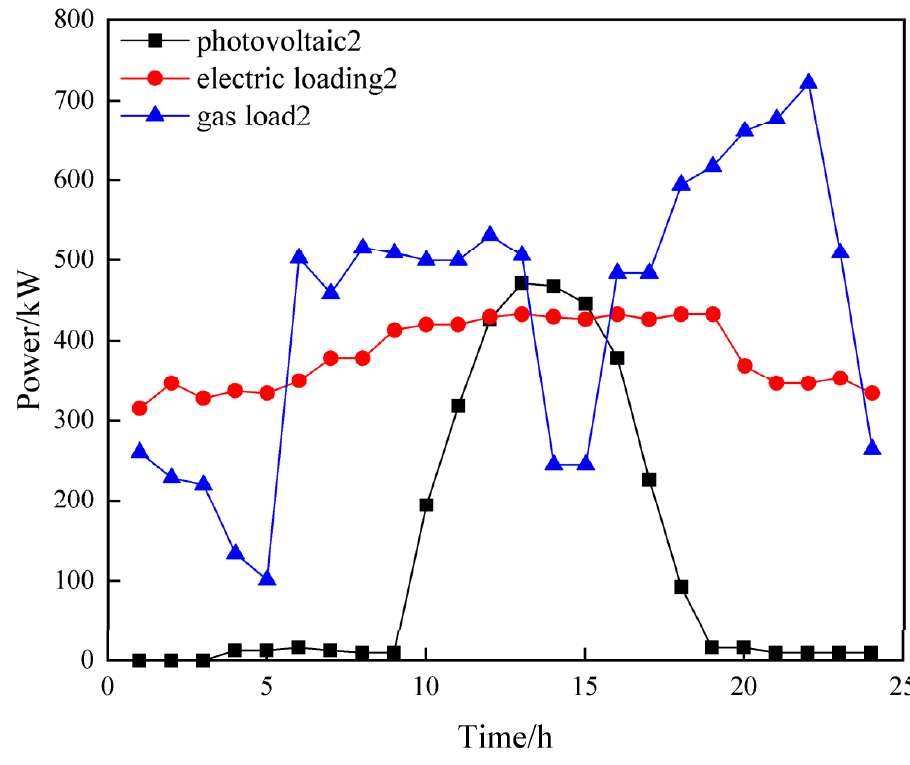
Figure 3. Predicted values of renewable energy output and load in system 1.